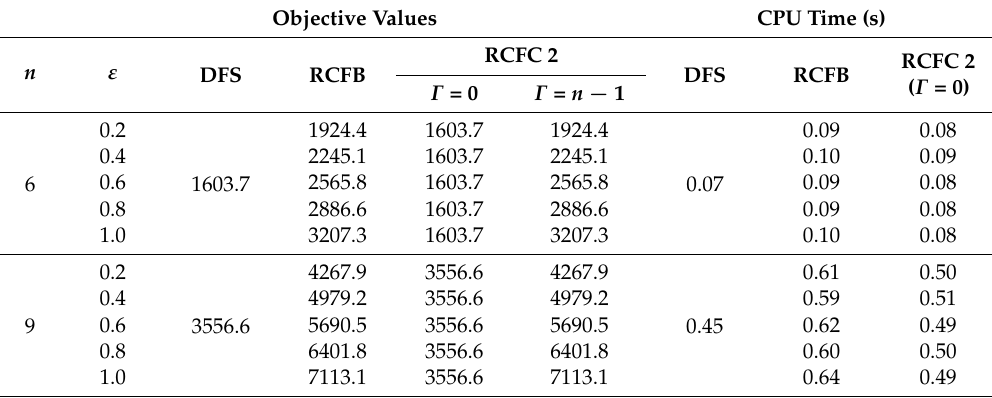
Table 1. Comparison of objective values and CPU times of DFS (deterministic fire scheduling), RCFB (robust counterpart formulation with box uncertainty), and RCFC 2 (robust counterpart formulation with cardinality-constrained uncertainty) with various Γ